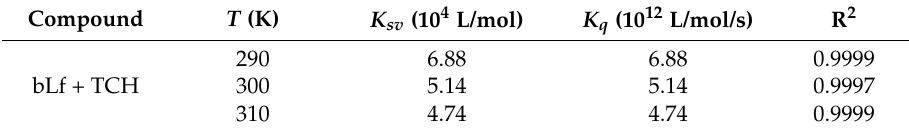
Table 1. The quenching constants of the interaction between bLf and TCH. Compound